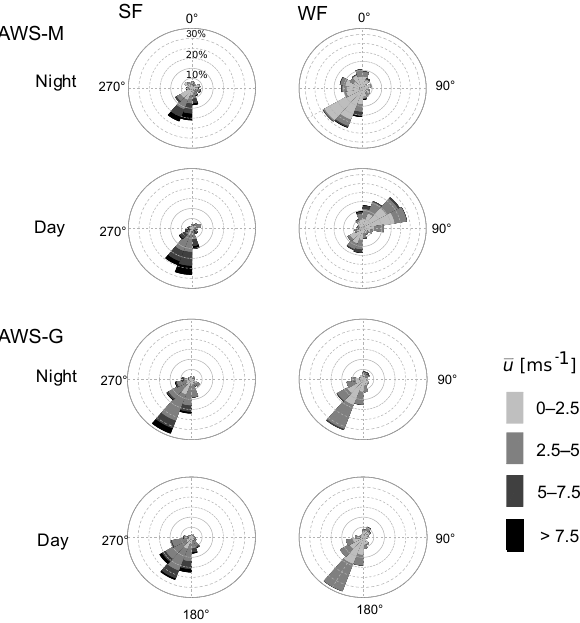
Figure 4. Rose diagrams of wind direction and speed measured by the AWS-G and the AWS-M for SF (left panels) and WF (right pan- els) conditions during the night (upper panels) and during the day (lower panels).